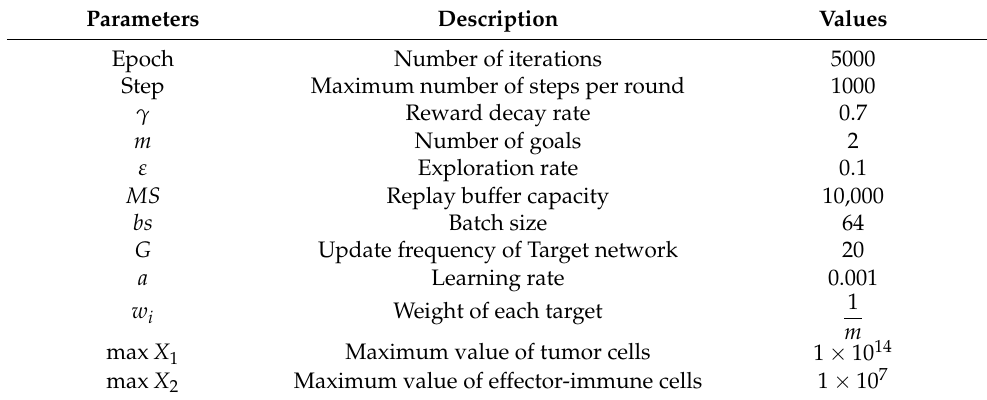
Table 2. Design of experimental parameters.